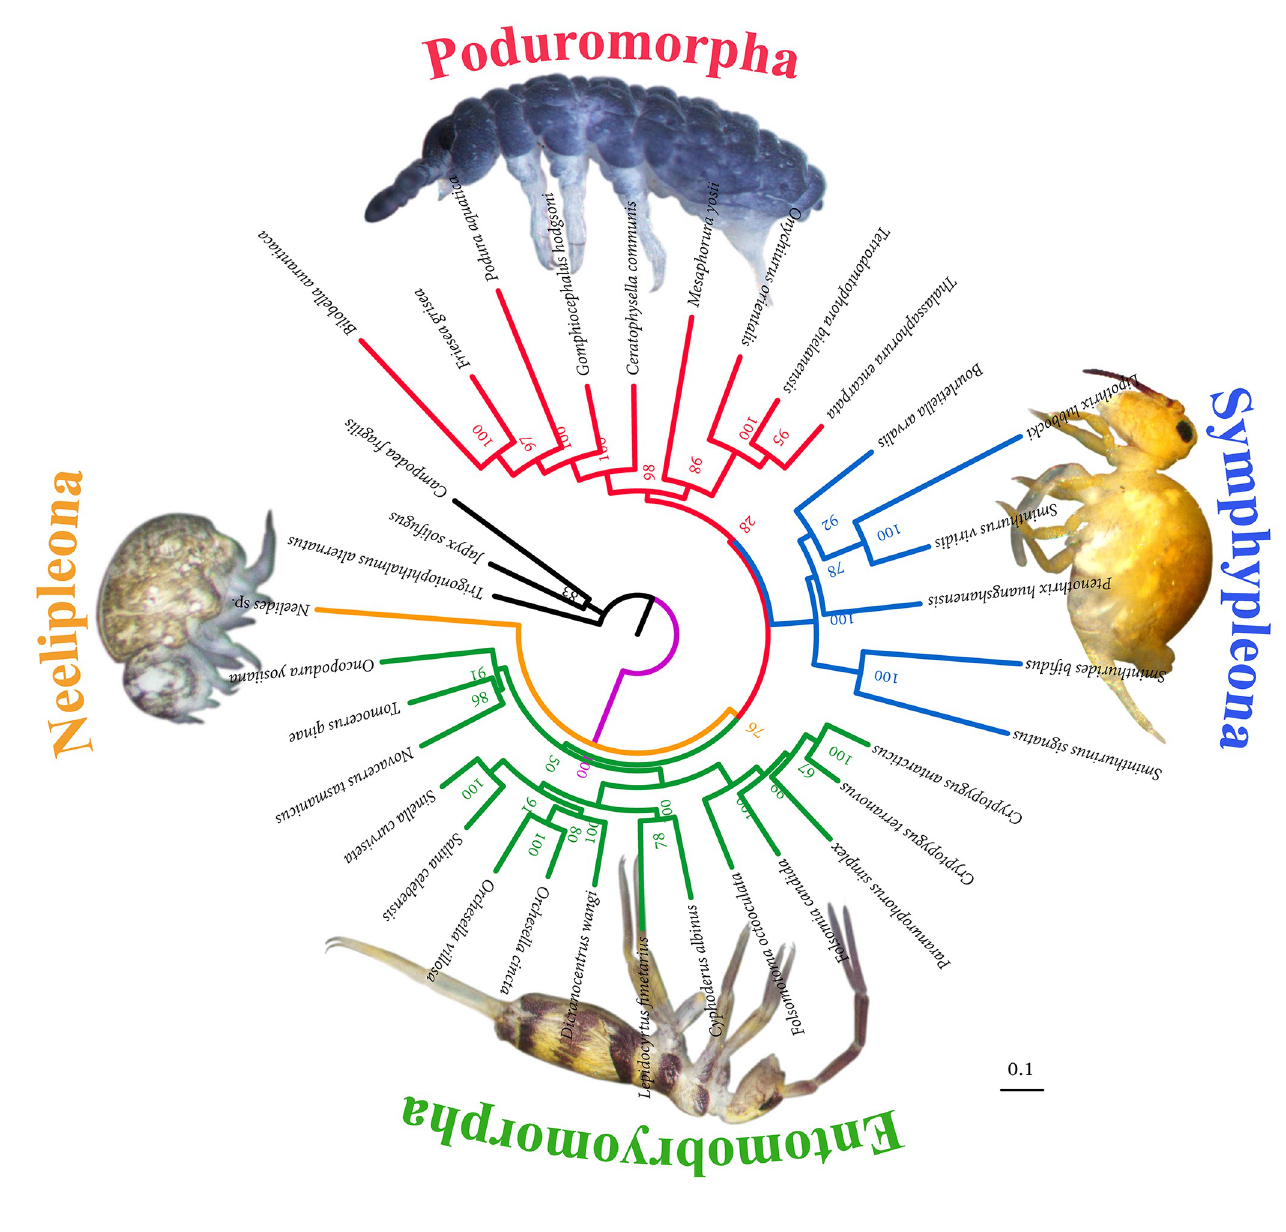
Fig 2. Maximum likelihood phylogenetic tree inferred from partitioned nucleotide sequences of 15 genes, with third codon position excluded (15fna_13PCGs (site1+2)_2rrn (2partition)). Bootstrap support values are shown in the nodes.